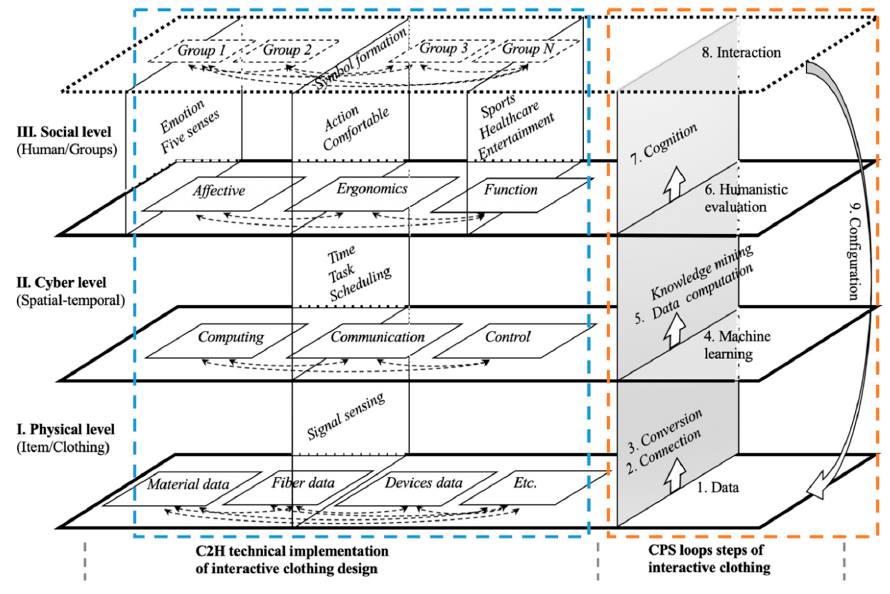
Figure 1. CPCS model.